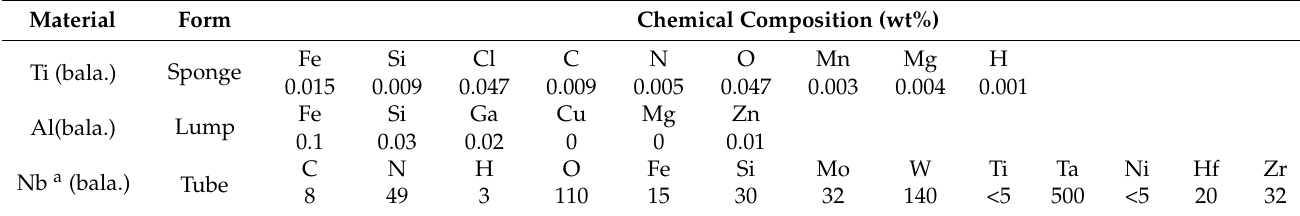
Table 1. Component and form of materials used in experiments.